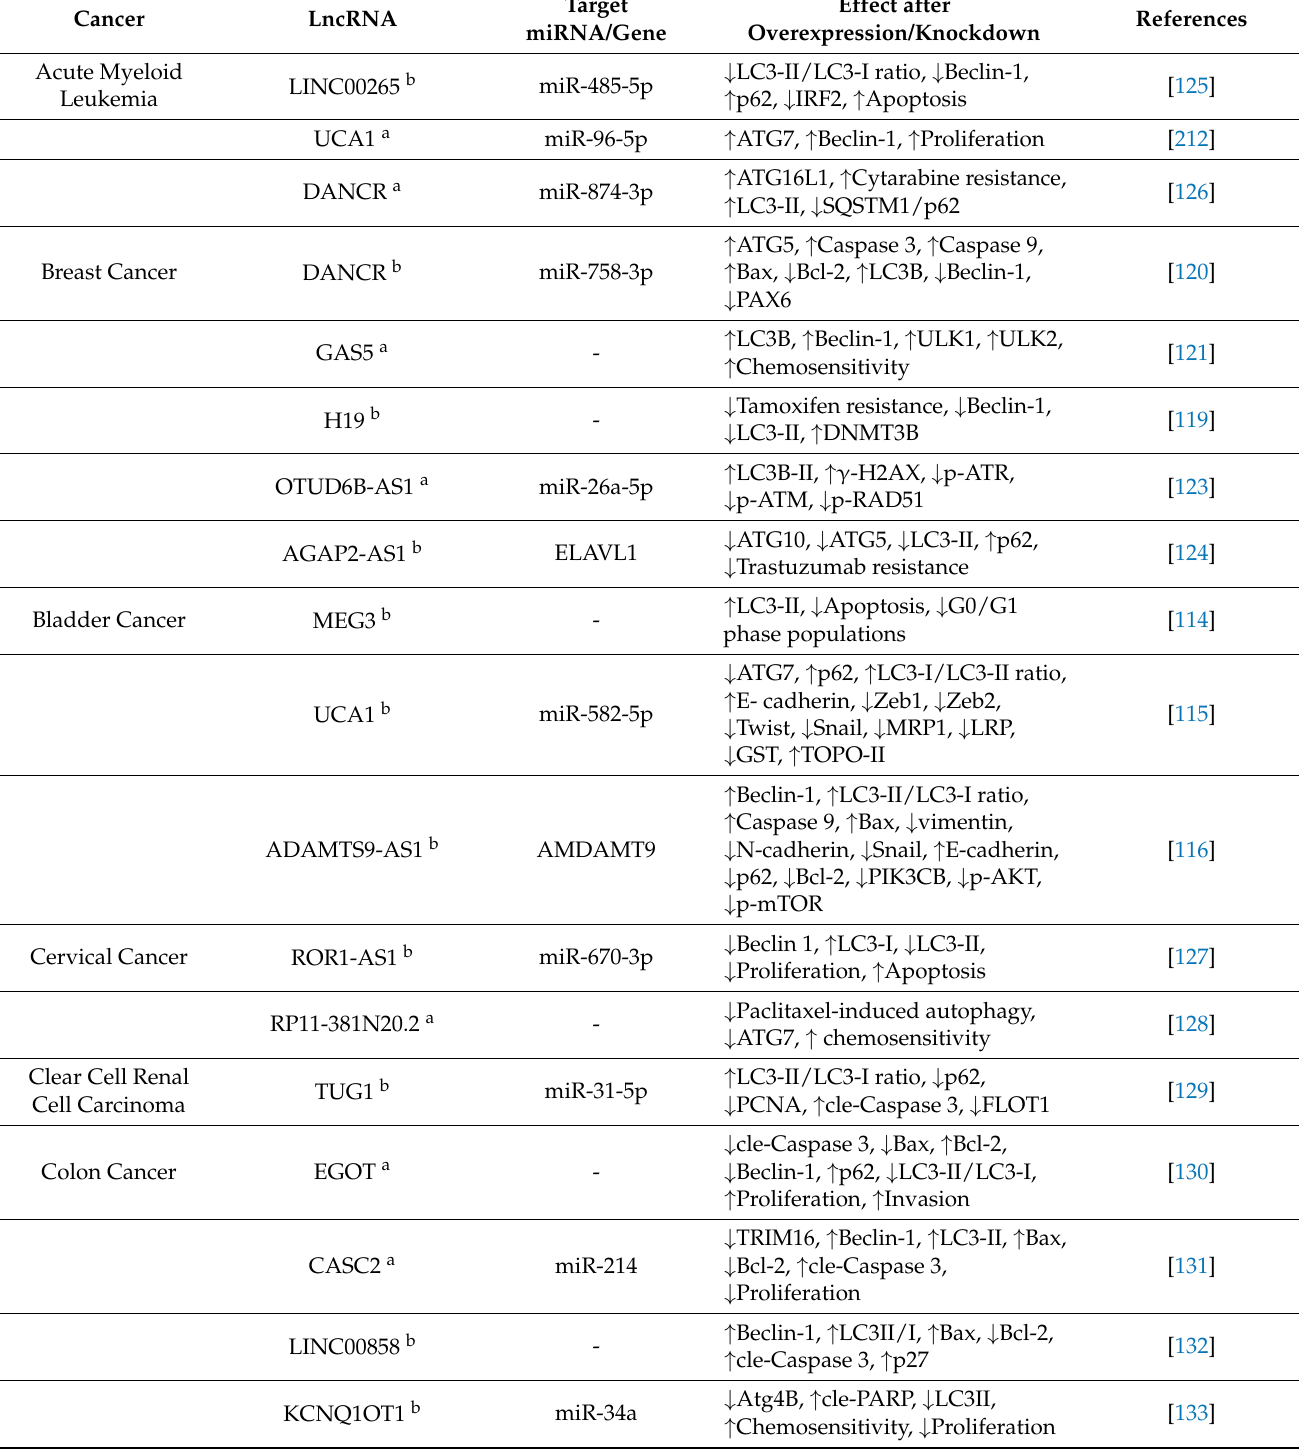
Table 2. LncRNAs and their mechanistic action in regulating autophagy in different